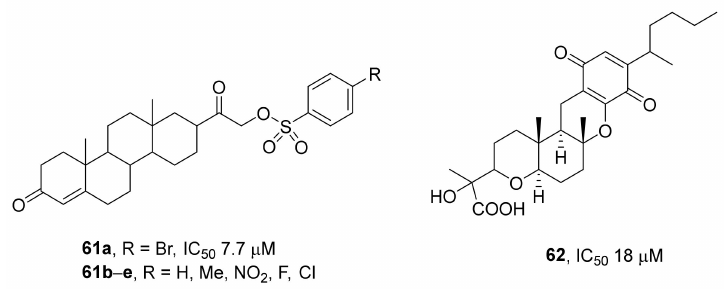
Figure 17. TDP1 inhibitors based on steroid derivatives.